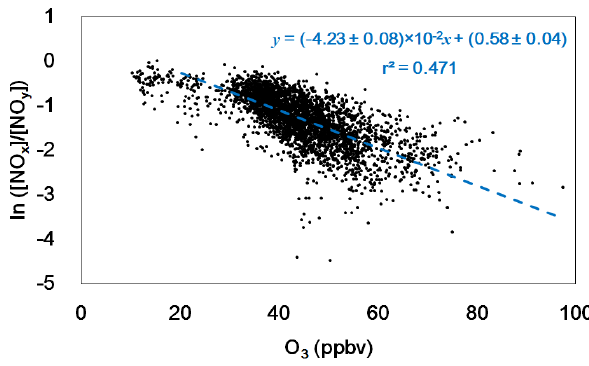
Figure 6. Time-series variation of photochemical age, t [OH], esti- mated from [NO x ] / [NO y ]